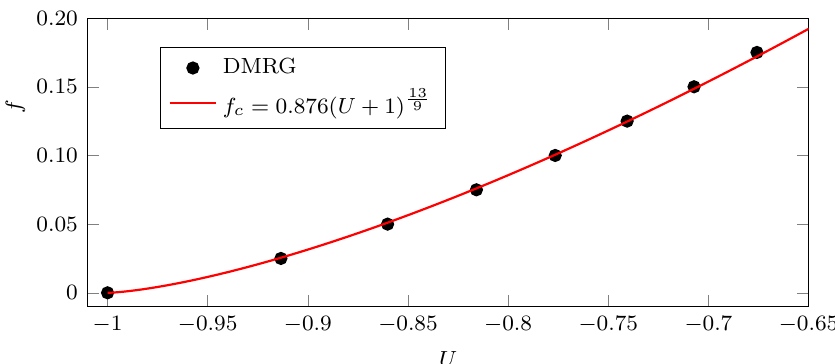
Figure 6: The phase boundary between the paramagnetic and topological phase. The dots are obtained with finite-size scaling from the DMRG calculation. The red line is the CFT prediction (29), with the prefactor obtained from a fit to the numerical